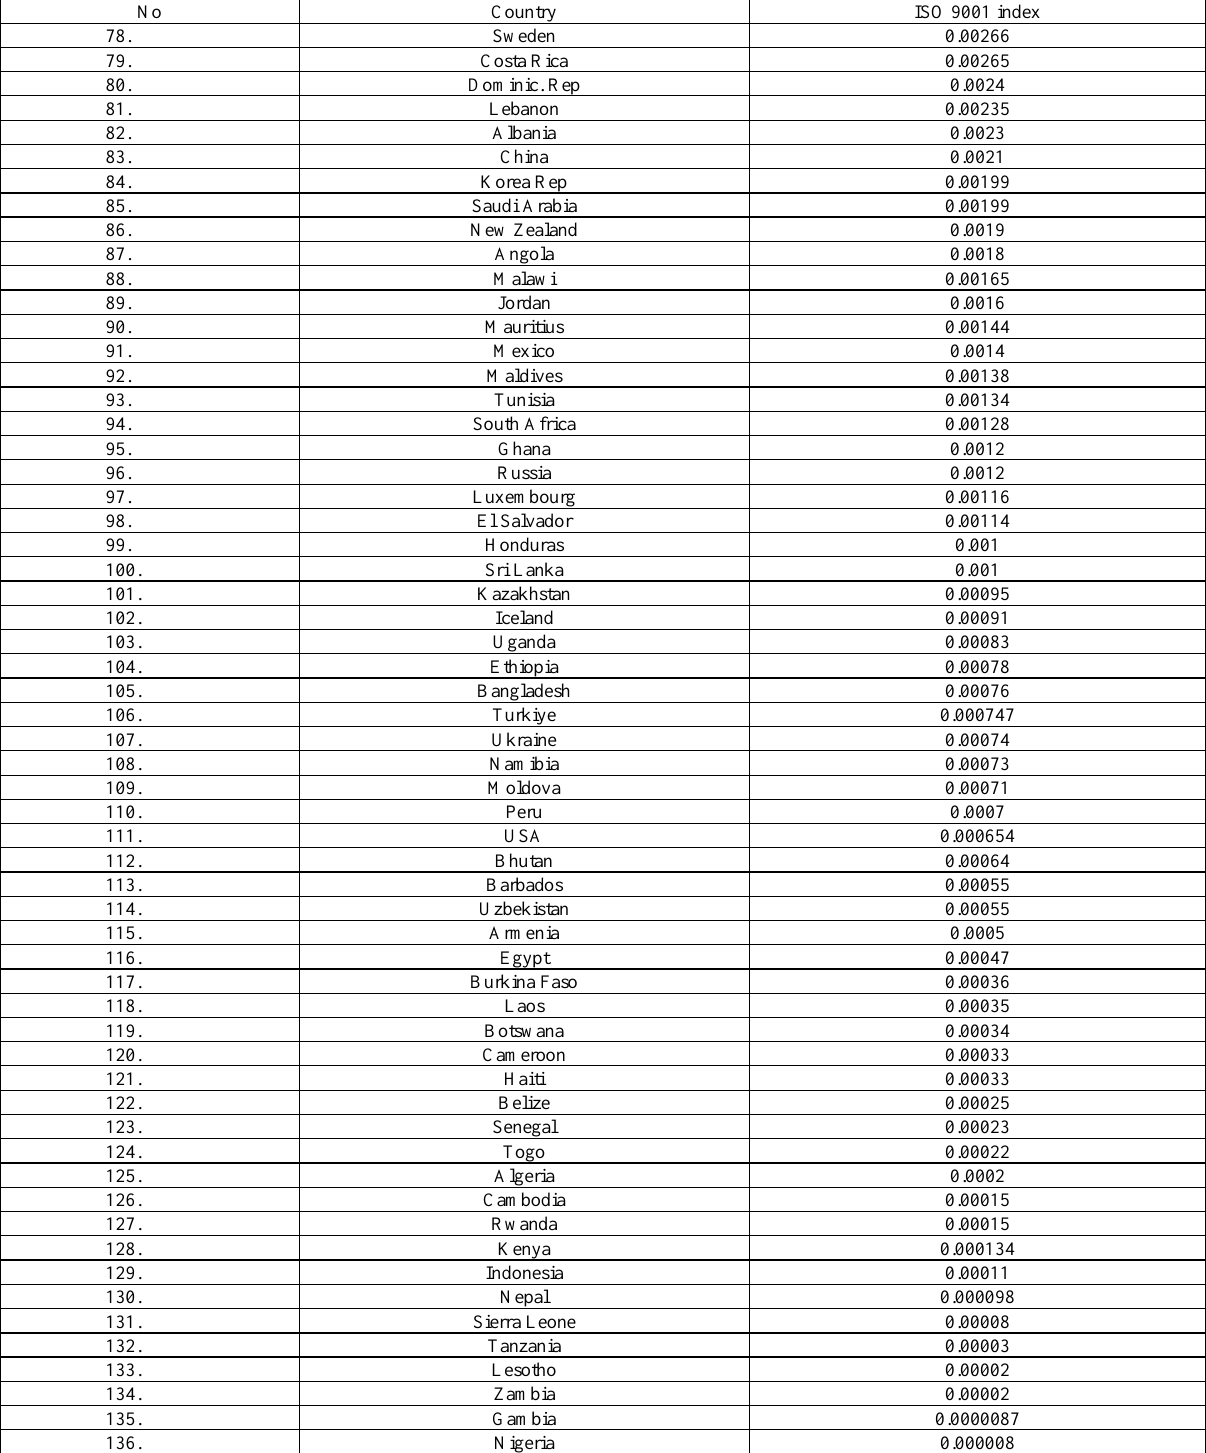
Table 3 (cont.). List of countries for ISO 9001 index based on the number of ISO 9001 certificates issued divided by the number of businesses per each country (136 countries worldwide, drawn from the author of